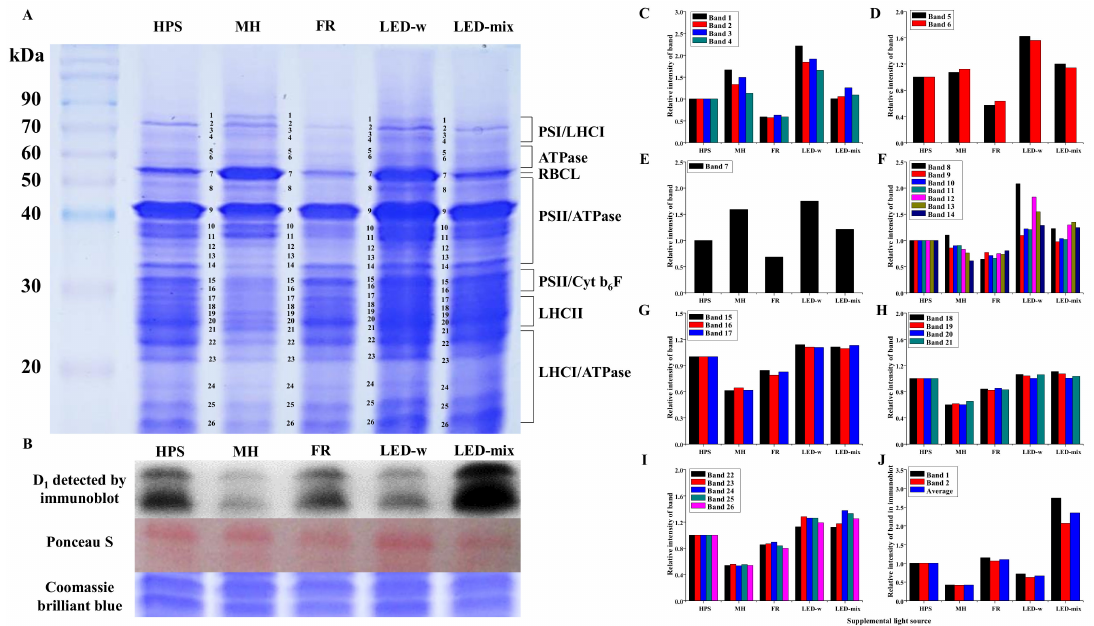
Figure 4. Chloroplast protein analysis ( A ) for C. lanceolata seedlings grown under supplementary light sources analyzed by sodium dodecyl sulfate polyacrylamide gel electrophoresis (SDS-PAGE), D 1 protein of PSII detected by immunoblot and stained by Ponceau S or Coommassie brilliant blue ( B ), and the relative intensities of these protein bands ( C – J ) in SDS-PAGE gels or immunoblot membranes. PSI, Photosystem I complexes; PSII, Photosystem II complexes; LHCI, Light-harvesting complex I; LHCII, Light-harvesting complex II; ATPase, ATP synthase; RBCL, Rubisco large chain or ribulose bisphosphate carboxylase large chain; Cyt b 6 f, Cytochrome b 6 f; D 1 , a core protein in PSII, coded by PsbA